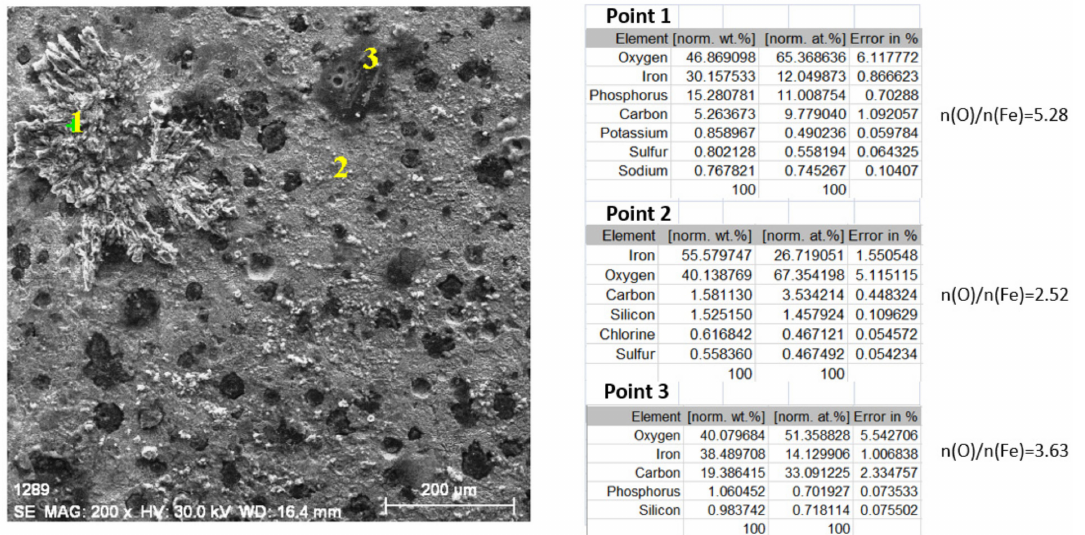
Figure 13. Punctual EDS microanalysis of the sample surface immersed for 30 days in